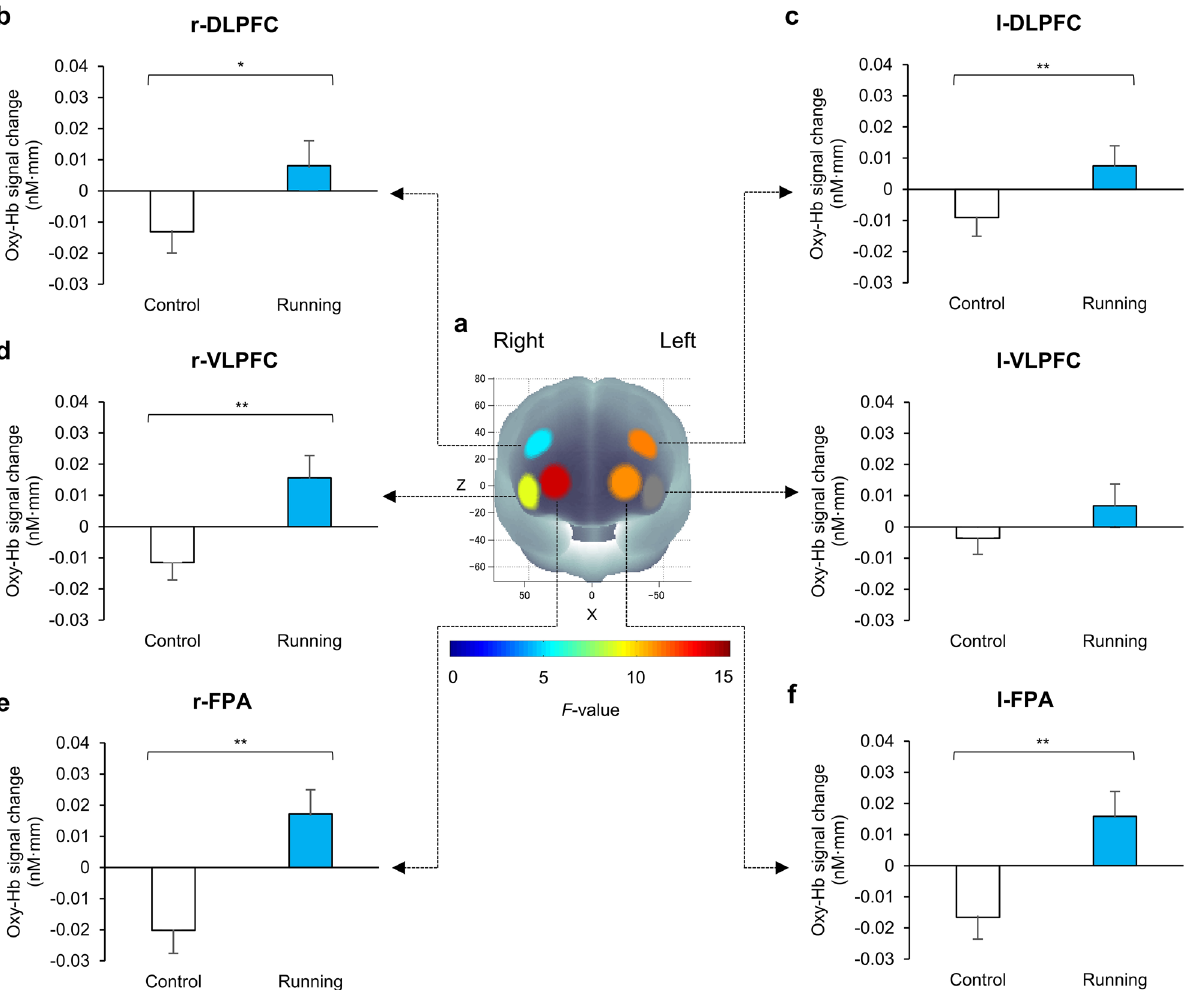
Figure 4. Running elicits prefrontal activation in response to the Stroop interference difference ([incongruent—neutral of post-session]—[incongruent—neutral of pre-session]). ( a ) F -map of oxygenated hemoglobin (Oxy-Hb) signal change, F -values are indicated as in the color bar. Among the 6 regions of interest (ROIs), significant differences are found in ( b ) the right dorsolateral prefrontal cortex, ( c ) the left dorsolateral prefrontal cortex, ( d ) the right ventrolateral prefrontal cortex, ( e ) the right frontopolar area and ( f ) the left frontopolar area. Data are mean ± SE, ** p < 0.01, * p < 0.05.